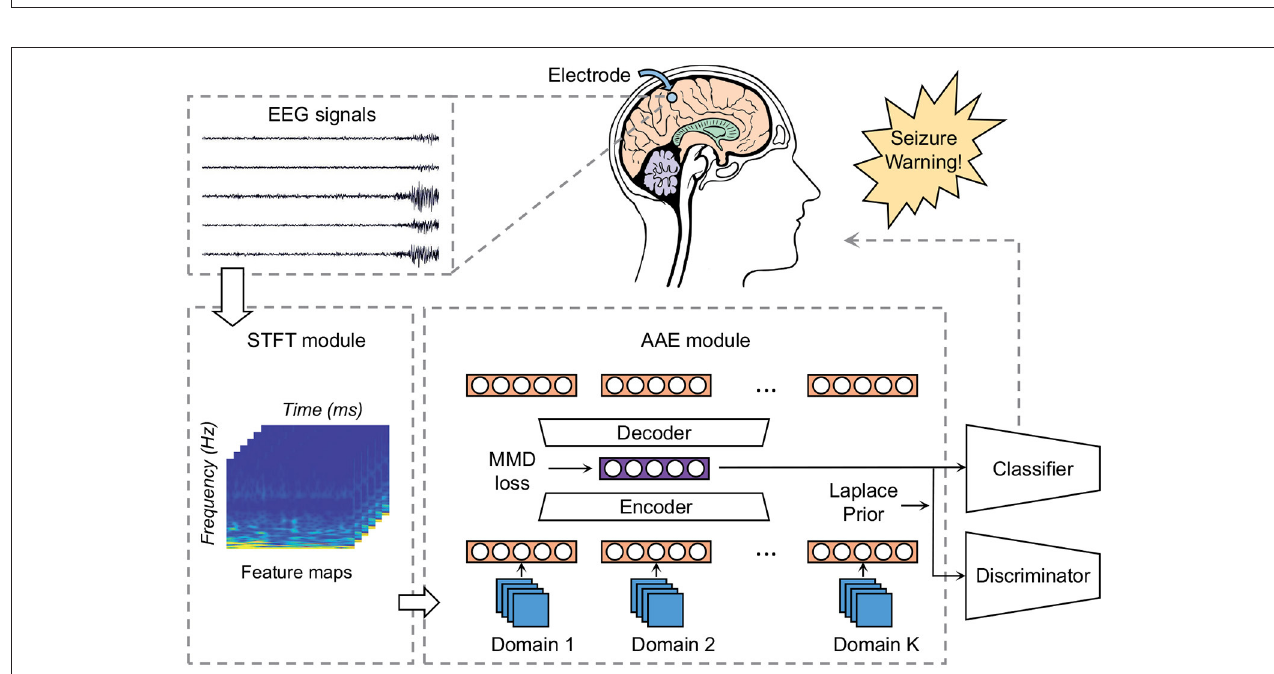
FIGURE 4 | Block diagram of our model: the STFT module converts raw EEG recordings into time-frequency images to meet the input requirement of the AAE module. The AAE module maps each domain’s data into a high-dimensional space. MMD loss is employed as the measure to align distributions of different domains. The Laplace prior is exploited to optimize the hidden code z using adversarial